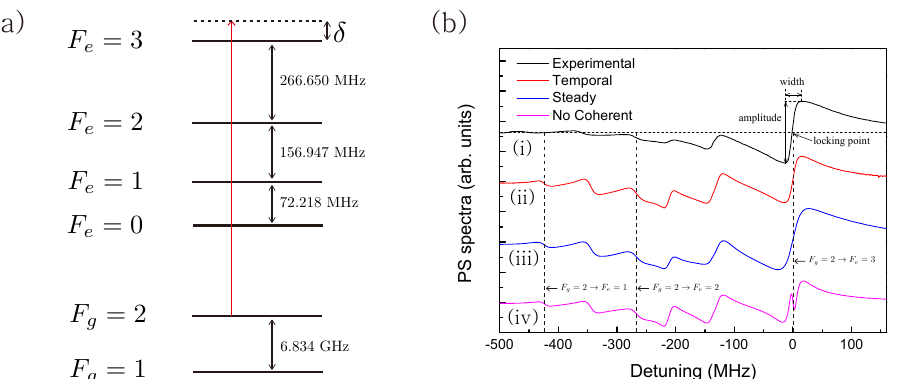
F e = 1,2,3 transitions in a D 2 line of 87 Rb Figure 2. ( a ) Typical energy diagram for the F g = 1,2 → F e = 3 transition line. atoms. The detuning δ represents the laser frequency relative to the F g = 2 → ( b ) (i) PS spectra measured experimentally (black line), and PS spectra calculated by (ii) the temporal calculation (red line), (iii) the steady-state calculation (blue line), and (iv) the calculation without the coherence terms (magenta line). The amplitude, width, and slope of the experimental PS spectra were compared with the results calculated, using the temporal calculation method (ii). The slope was F e = 3 resonance estimated at the locking point, F g = 2 →